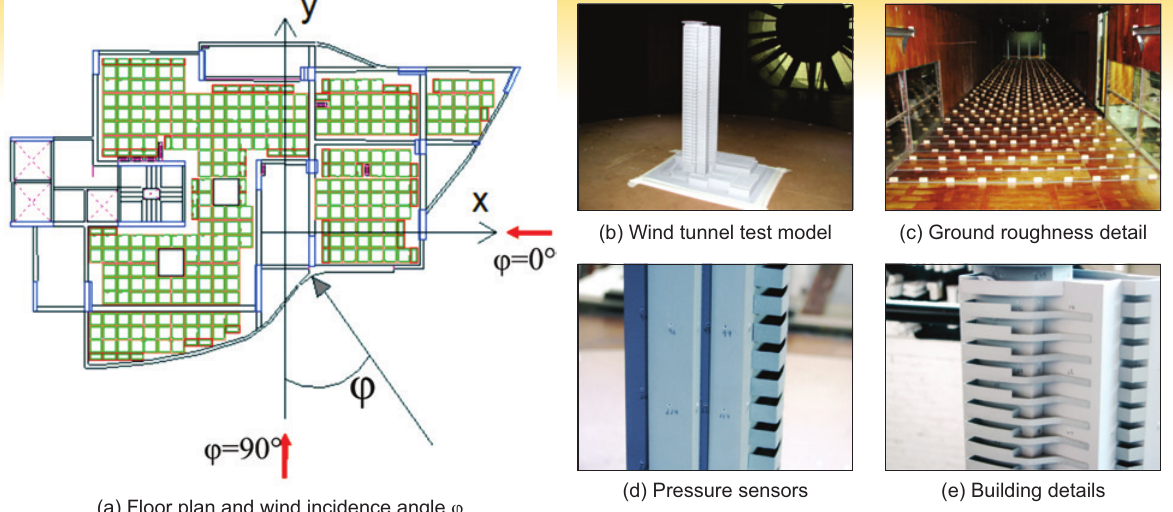
Figure 7 Wind tunnel test and details (Model 04) (IPT